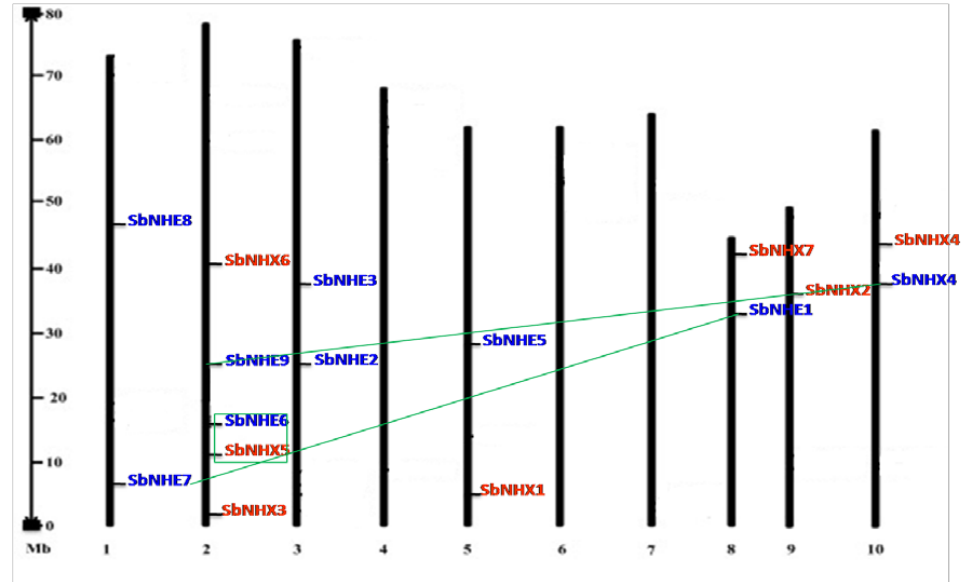
Figure 5. Physical mapping of Sorghum NHX/NHE genes. The three paralog gene pairs are represented with lines ( SbNHE1 and SbNHE7 , SbNHX4 and SbNHE9 ) and a box ( SbNHX5 and SbNHE9 ). All the SbNHX genes are represented in maroon and all SbNHE genes in blue.